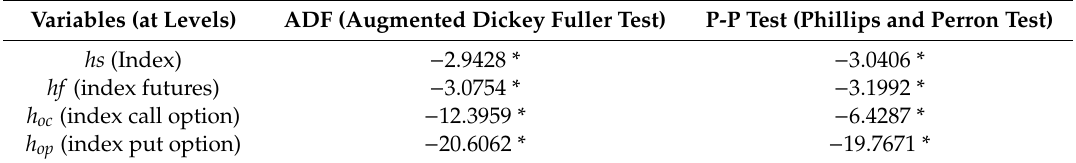
Table 2. Test of